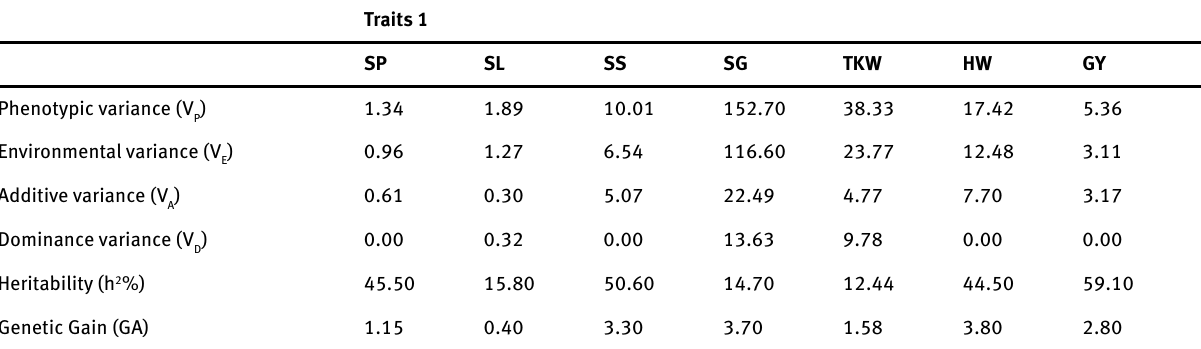
Table 3: Variance components, narrow-sense heritability and expected genetic gain of quantitative traits in CIMMYT 820 x Don Santiago INTA triticale cross